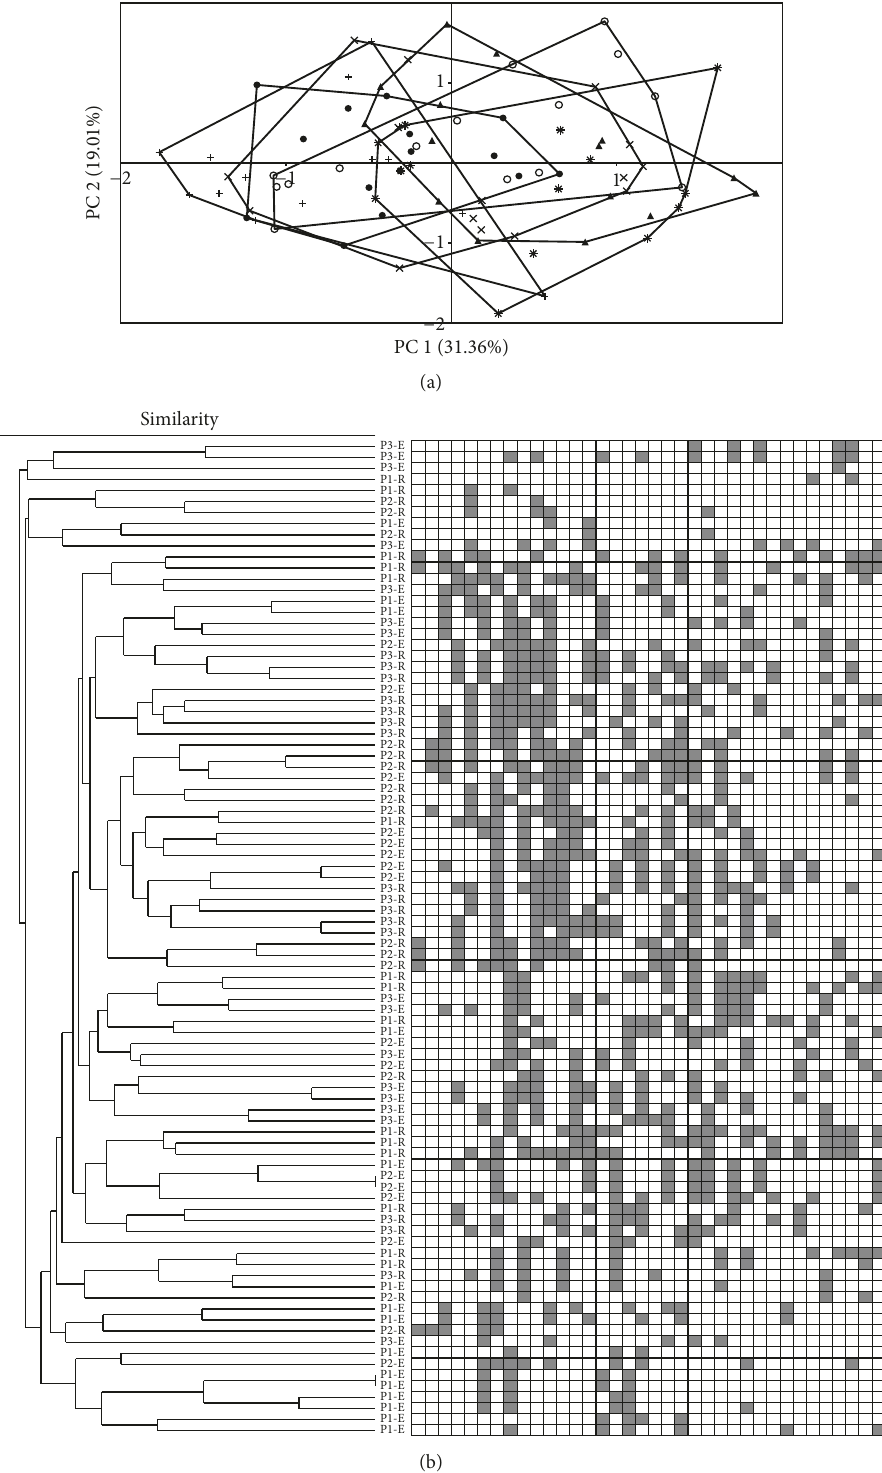
Figure 1: Principal component (PC) analysis (a) and dendogram of the binary matrix (b) of the diversity of cultivated potentially diazotrophic bacteria determined through Polymerase Chain Reaction (BOX-PCR) in different niches of plant/bacteria association in B. decumbens Stapf. pasture in different stages of degradation. × represents highly degraded pasture and rhizospheric soil niche; + represents highly degraded pasture and root-endophytic niche; I represents partially degraded pasture and rhizospheric soil niche; ∗ represents partially degraded pasture and root-endophytic niche; 󳵳 represents slightly degraded pasture and rhizospheric soil niche; and e represents slightly degraded pasture and root-endophytic